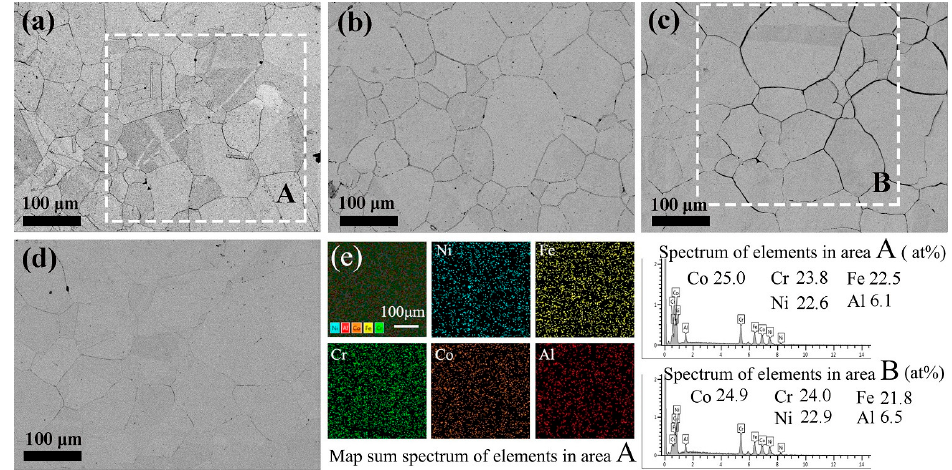
Figure 3. BSE images of various thicknesses Al 0.25 CoCrFeNi HEAs annealed for 10 h at 1100 °C: ( a ) 400 μ m; ( b ) 800 μ m; ( c ) 1000 μ m; ( d ) 1500 μ m; and ( e ) shows the spectrum of the elements in area A.